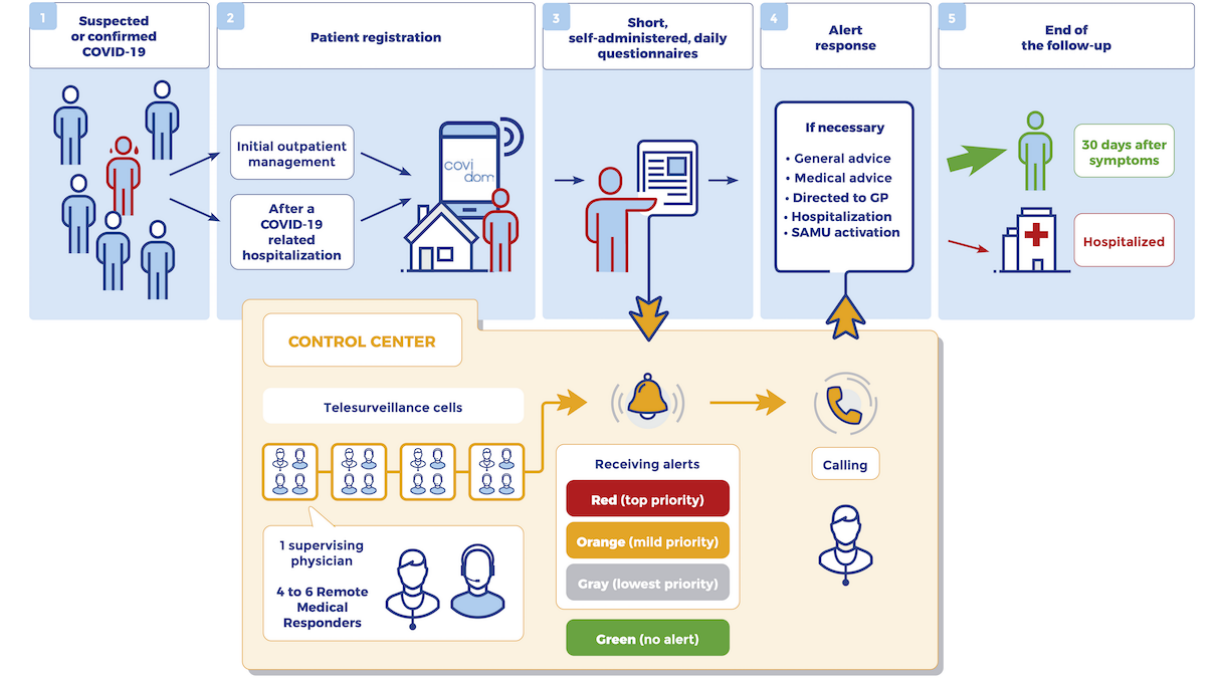
Figure 1. The Covidom solution: patient pathway and regional control center organization. GP: general practitioner, SAMU: Service d’Aide Médicale